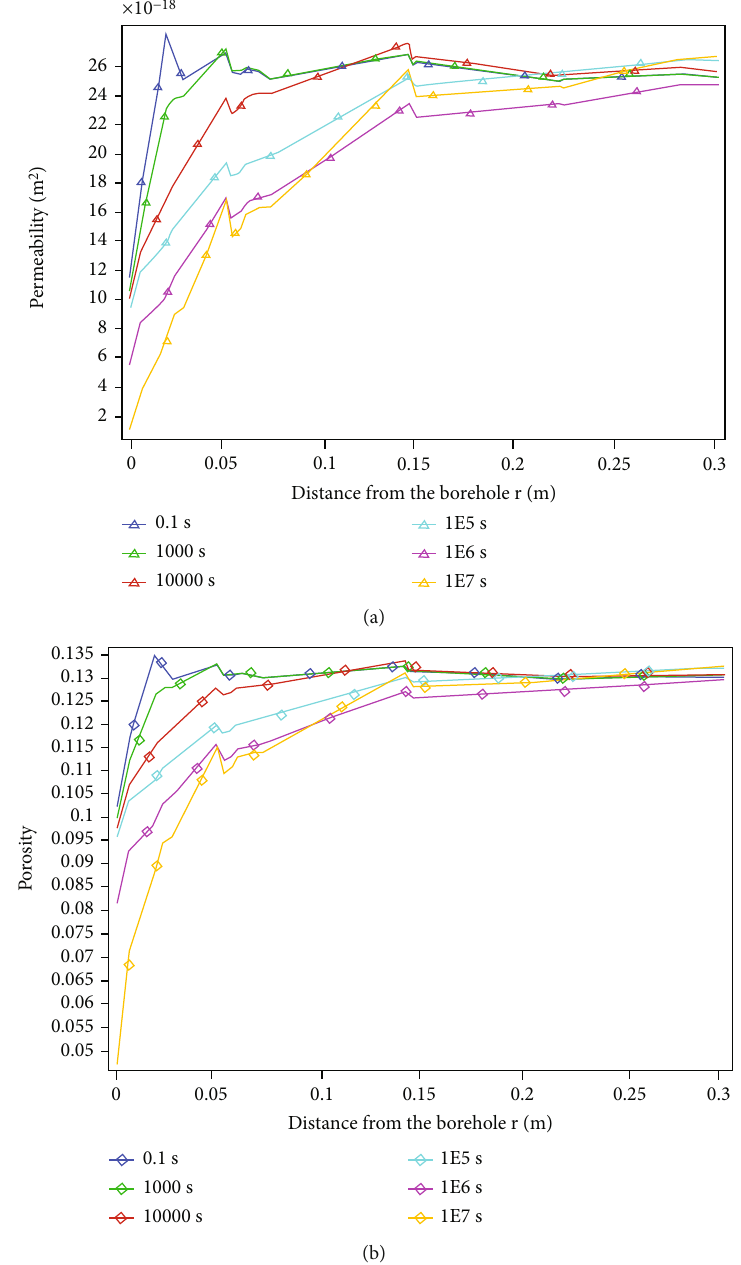
Figure 20: (a) Permeability and (b) porosity in the m = 5 coal rock during CBM